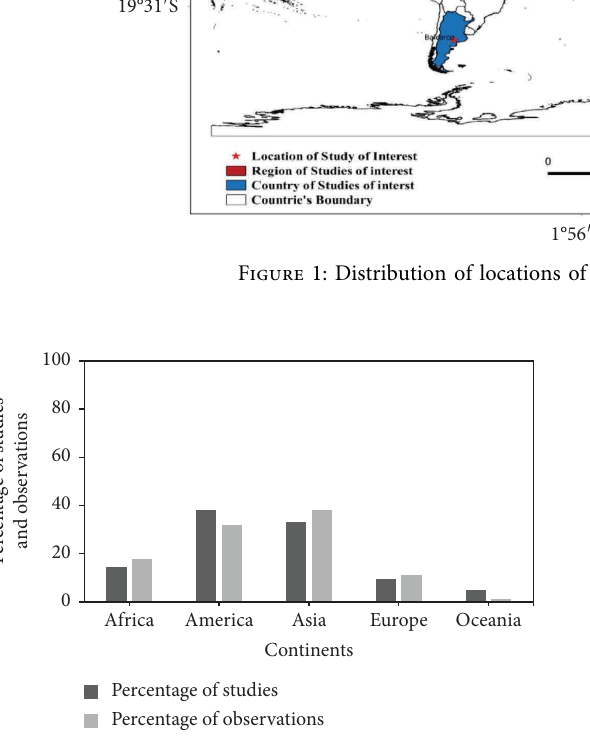
Figure 2: Distribution of studies across continents.